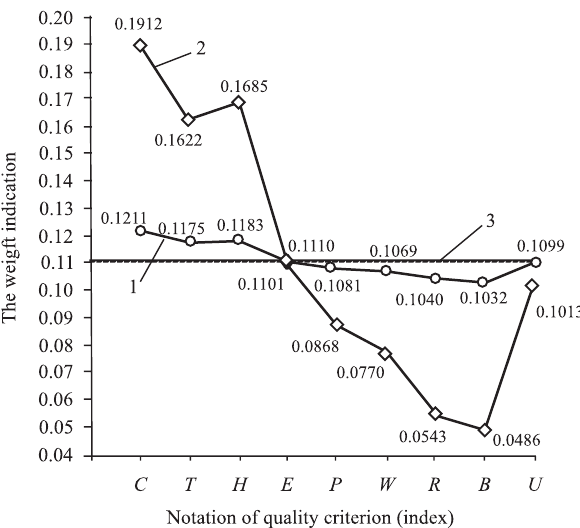
Fig. 2. Values of AMP quality criteria significance